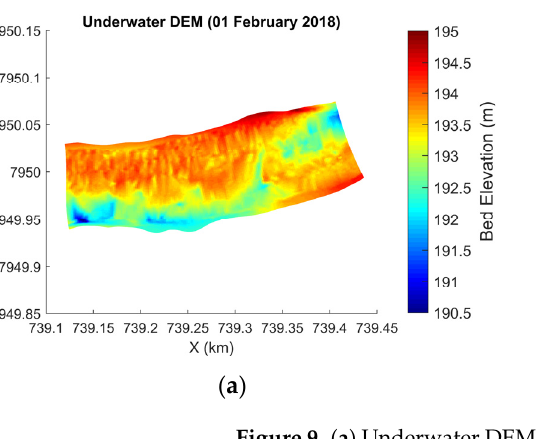
Figure 11. Unit bedload transport rates estimated with Helley-Smith sampler versus depth- averaged water velocities.